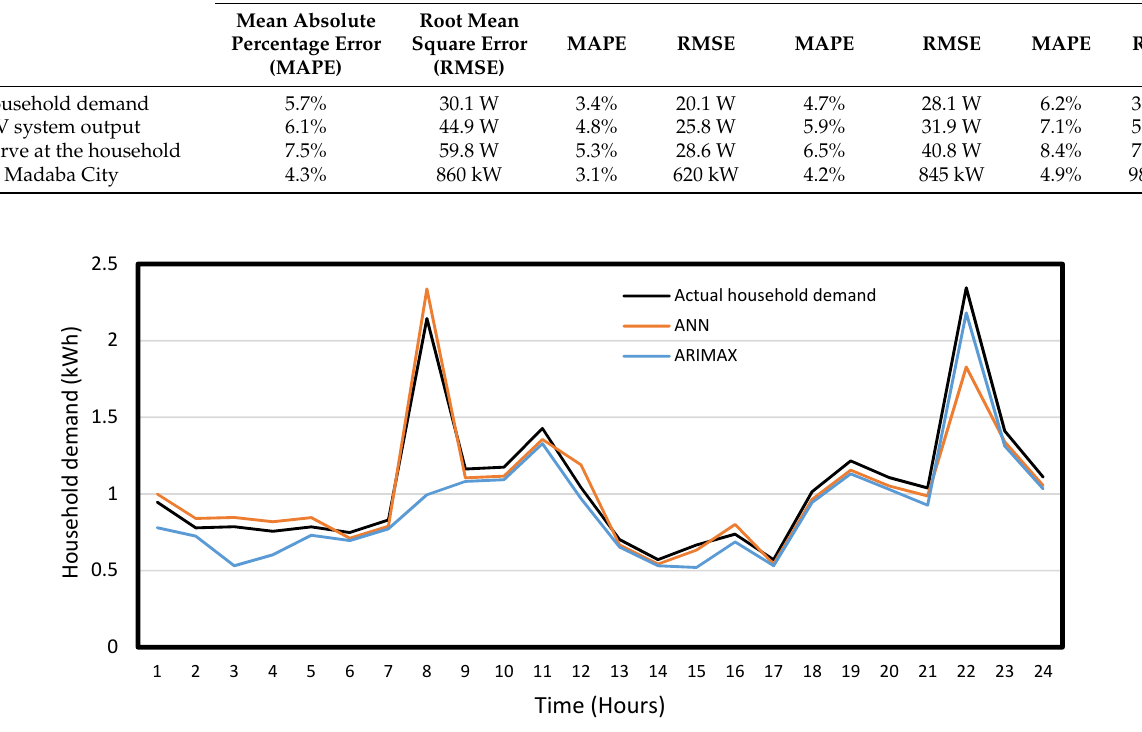
Figure 19. An example of actual and forecast household demand profile results.